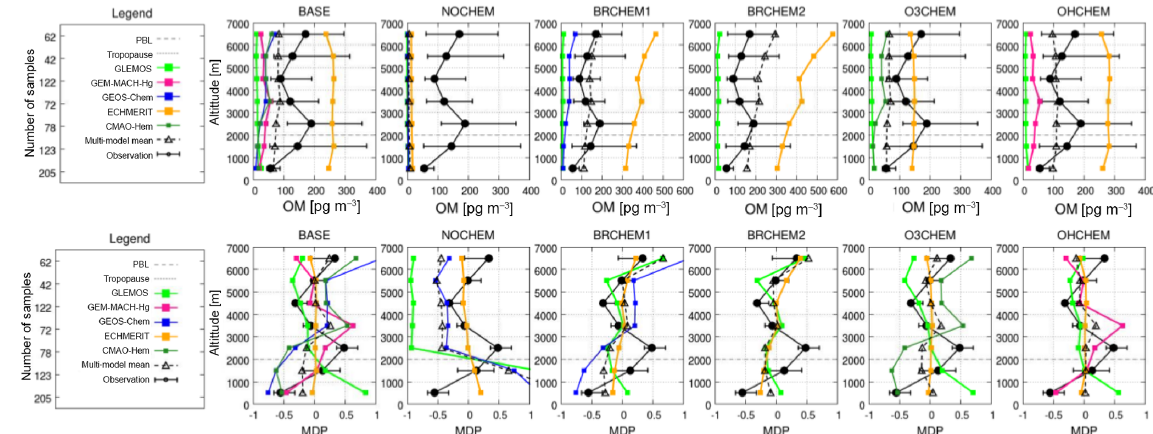
Figure 10. Comparison of modeled average oxidized mercury (OM) concentration to observations based on NOMADSS flights in June and July 2013 (Shah et al., 2016; Gratz et al., 2016). The error bars indicate the 66% quantile range of the observations in each altitude; the sample size for each altitude is indicated on the y axis of the